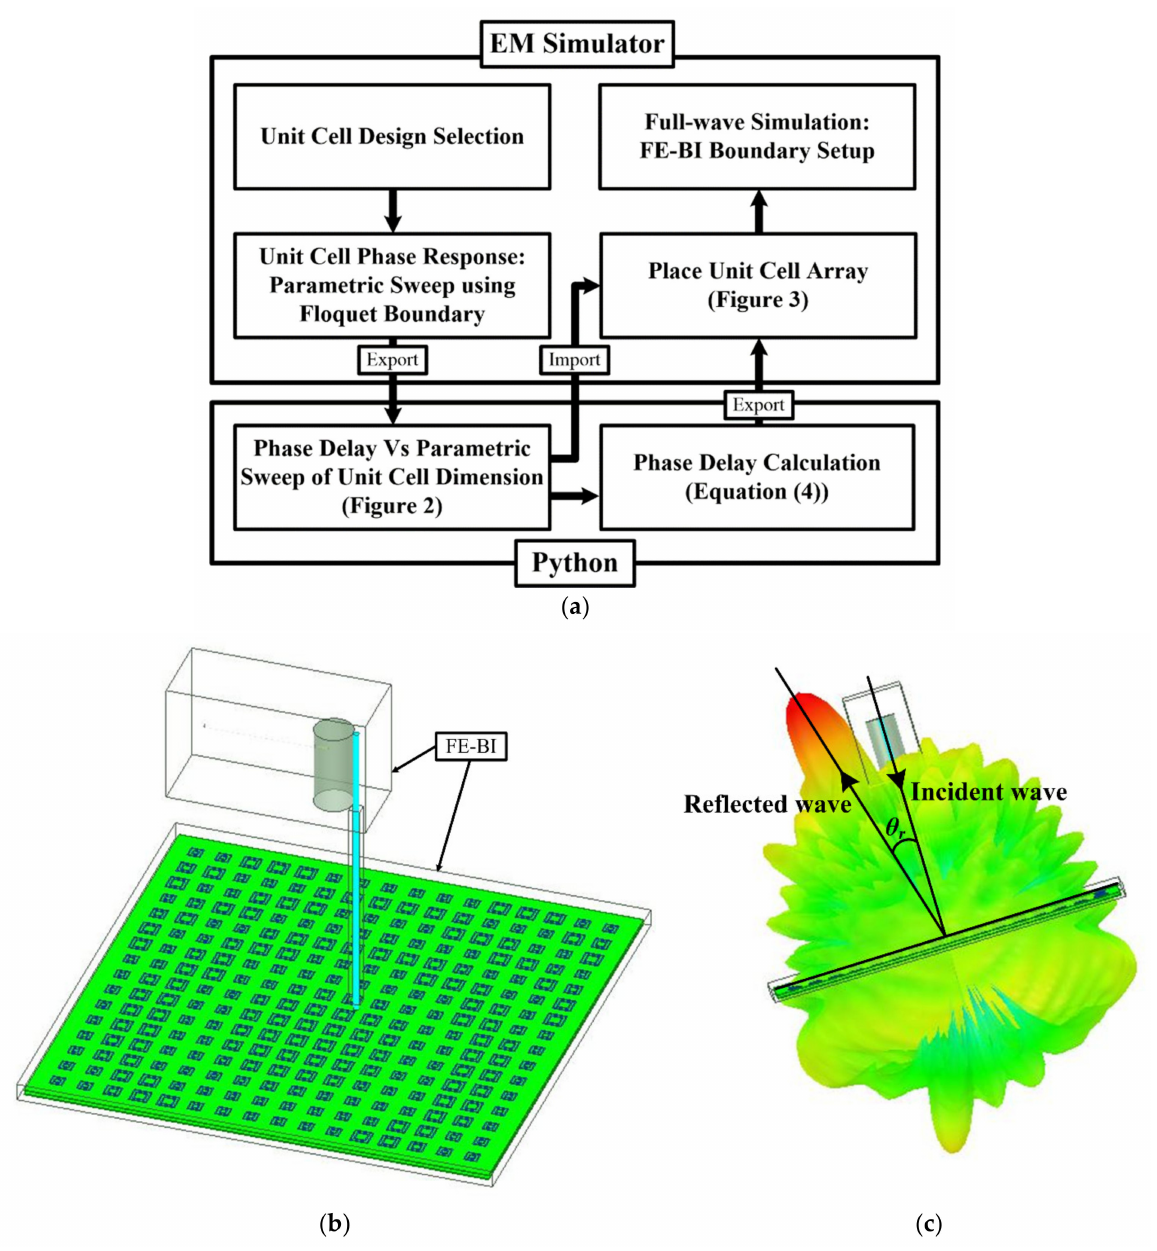
Figure 4. ( a ) Overall design procedure of the proposed reflectarray, ( b ) FE-BI domain decomposition simulation setup and ( c ) simulated radiation pattern of the designed reflectarray